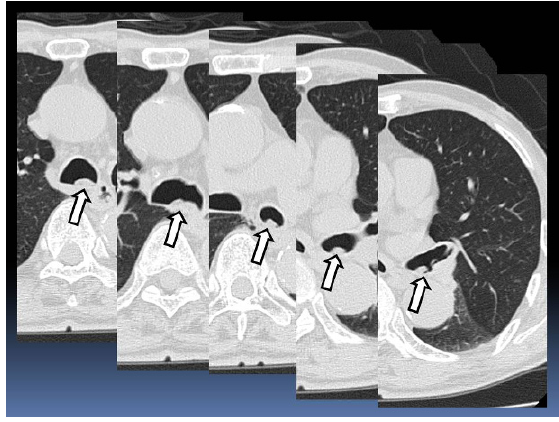
Figure 1. CT scan revealed a mass-like opacity within the lower part of trachea and left main bronchus attached to the posterior